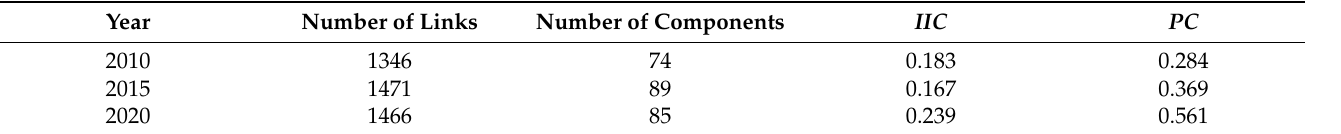
Table 4. The value of the Integral Connectivity of the Landscape in the Study Area from 2010 to